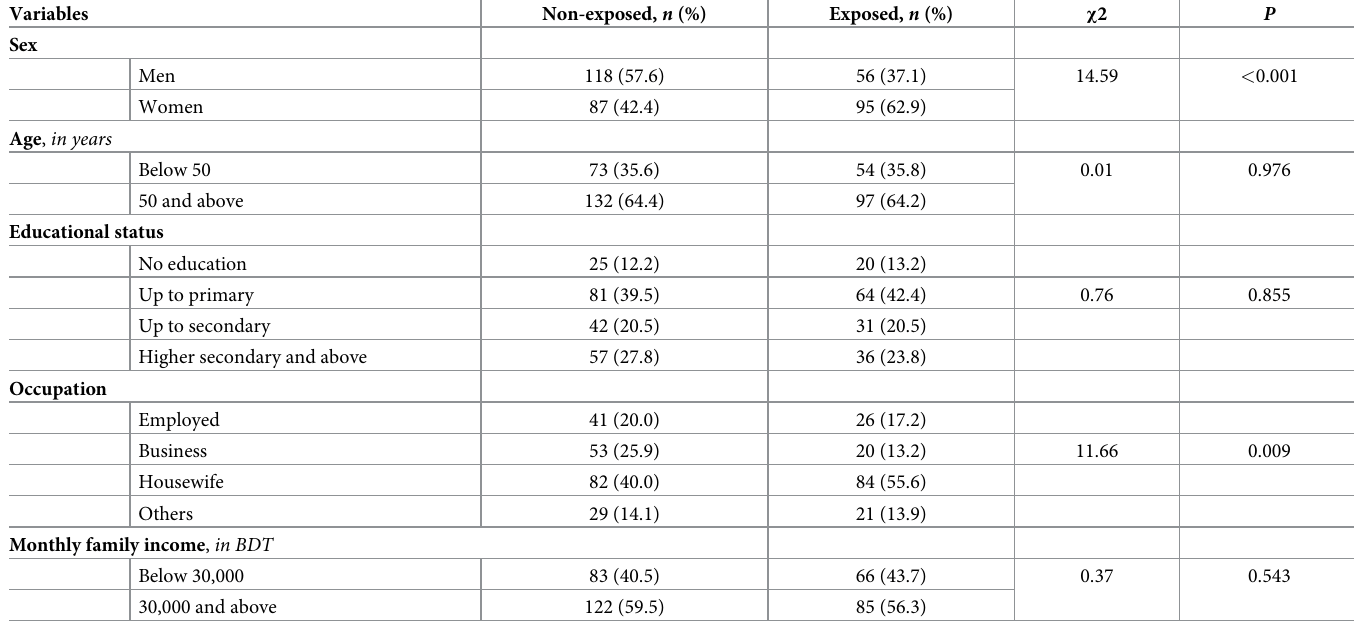
Table 1. Socio-demographic characteristics of the high groundwater salinity non-exposed ( n = 205) and exposed ( n = 151) diabetic populations in Bangladesh (total n =